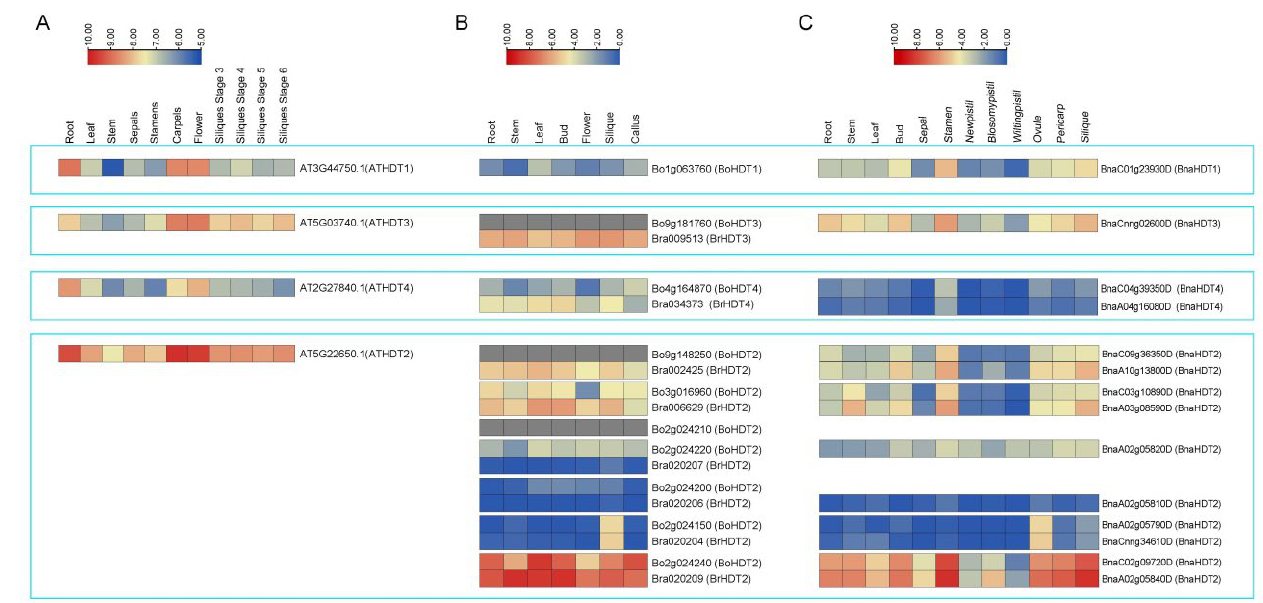
Figure 4. Expression of AtHDT ( A ), BraHDT and BoHDT ( B ), BnaHDT ( C ) in different tissues and organs. The expression levels (log10(FPKM) value) of HDT genes were indicated by differently colored rectangles.